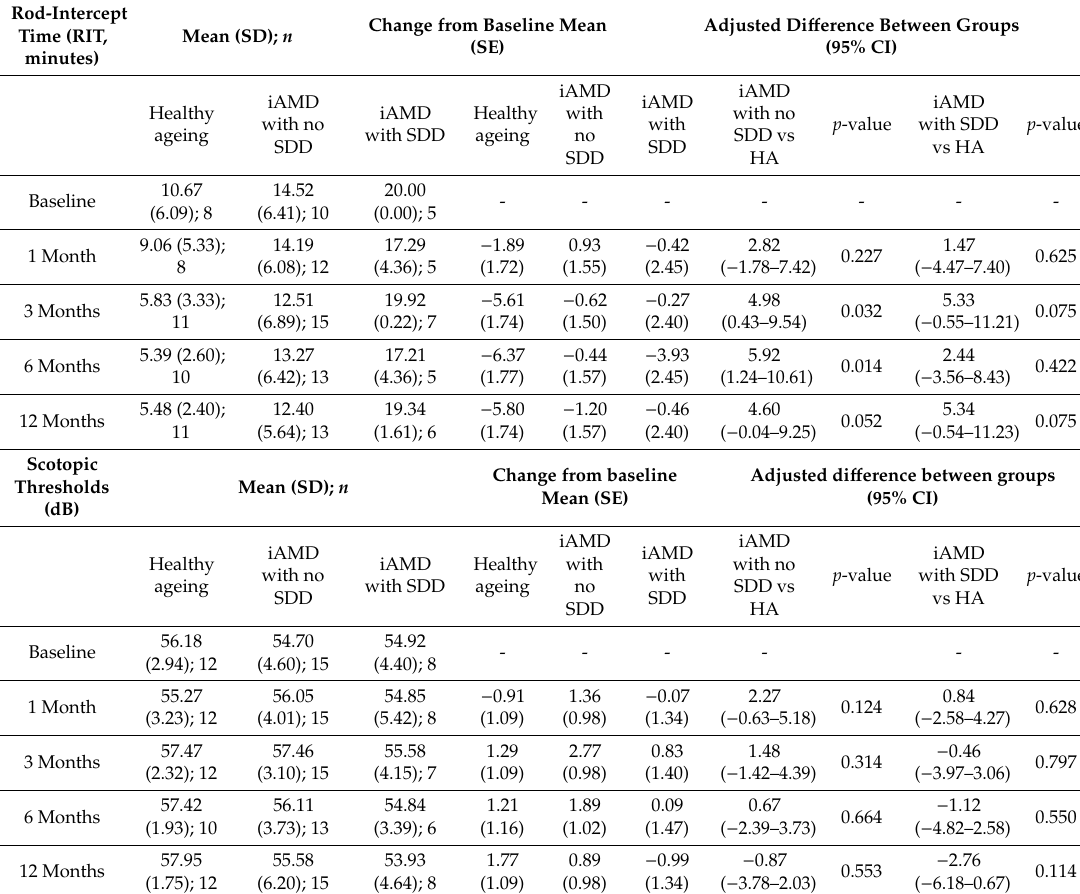
Table 4. Change in rod function outcome measures; scotopic threshold and rod-intercept time (RIT). Rod-Intercept Time